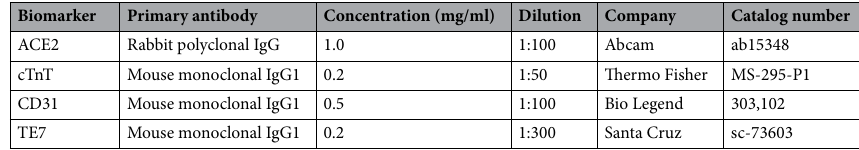
Table 3. Antibodies used for immunohistochemistry. Thermo Fisher = Thermo Fisher Scientific, Santa Cruz = Santa Cruz Biotechnology.